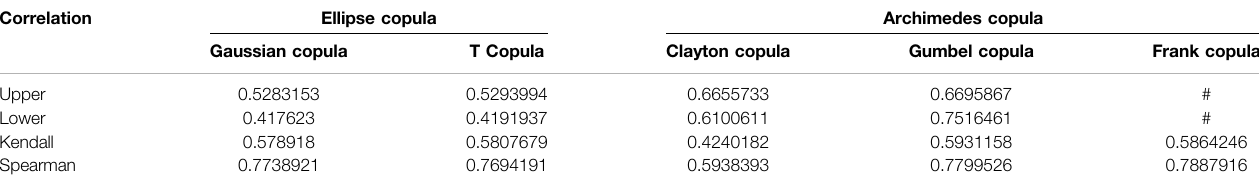
TABLE 3 | Parameters estimation and correlation analysis of copula